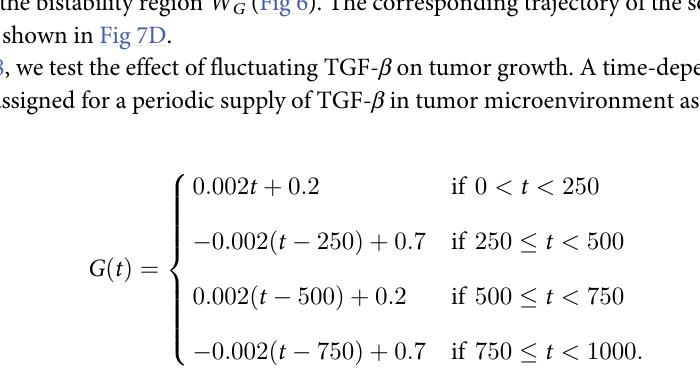
In response to the initial increasing TGF- β level, the trajectory of the solution C ( t ) follows the lower branches of the hysteresis bifurcation loop (thick gray curve) and jumps to the upper branch (Fig 8B). However, a decrease in G around t = 250 switches the moving direction of the solution and it follows the upper branch in the bi-stability region until it jumps down to the lower branch near the left knee of the hysteresis curve. This flow of the solution ( G ( t ), C ( t )) was marked in red arrows with initial position on the left lower corner (Fig 8B). The blue dashed curve and blue arrows represent the solution ( G ( t ), I ( t )) and its flow, respectively, in the opposite side (Fig 8B). The detailed time courses of solutions ( C ( t ), I ( t )) in response to the